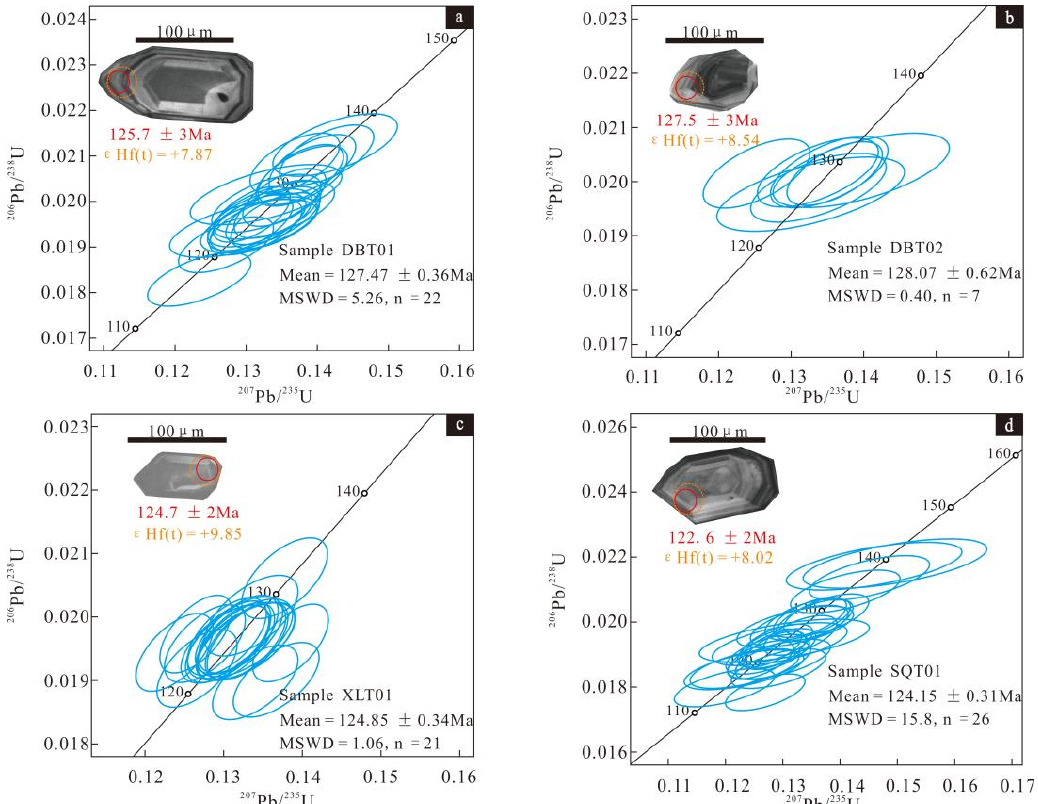
Figure 4. LA–ICP–MS Zircon 207 Pb/ 235 U- 206 Pb/ 238 U concordia diagrams of the Early Cretaceous intrusive rocks in the study area: ( a ) quartz monzonite porphyry; ( b ) monzonite porphyry; ( c ) quartz porphyry; ( d ) granite porphyry. Red circles represent U–Pb age analytical spots; orange circles represent Hf isotope analytical spots.